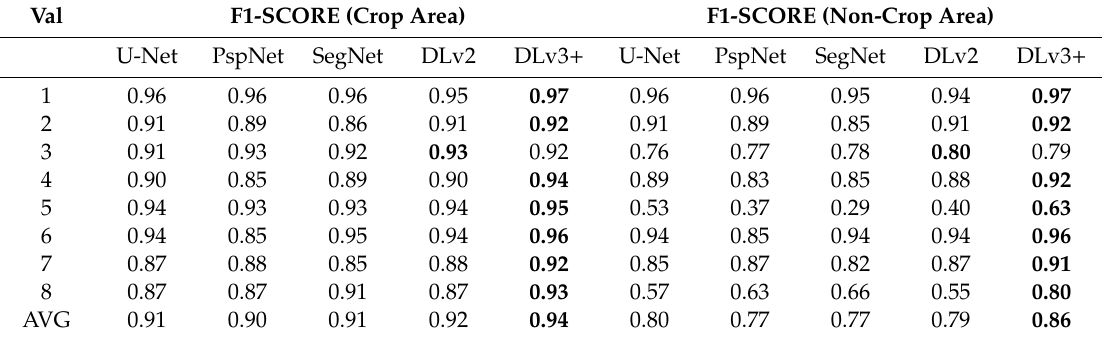
Table 4. Comparisons of U-Net, PspNet, SegNet, DeepLabv2 (DLv2), and DeepLabv3 + (DLv3 + ) on pixel-wise